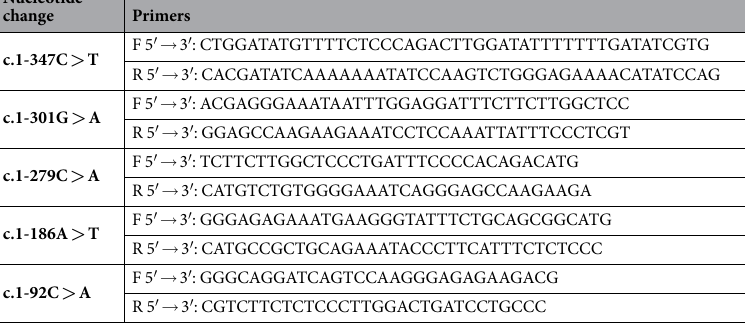
Table 7. Primer sequences for mutagenesis in 5 ′ UTR region of the BMPR2 gene. F: Forward; R: